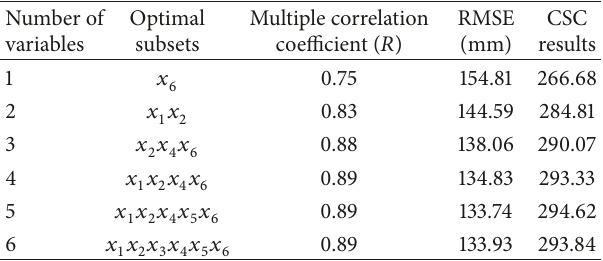
Table 2: All possible optimal regression subsets.